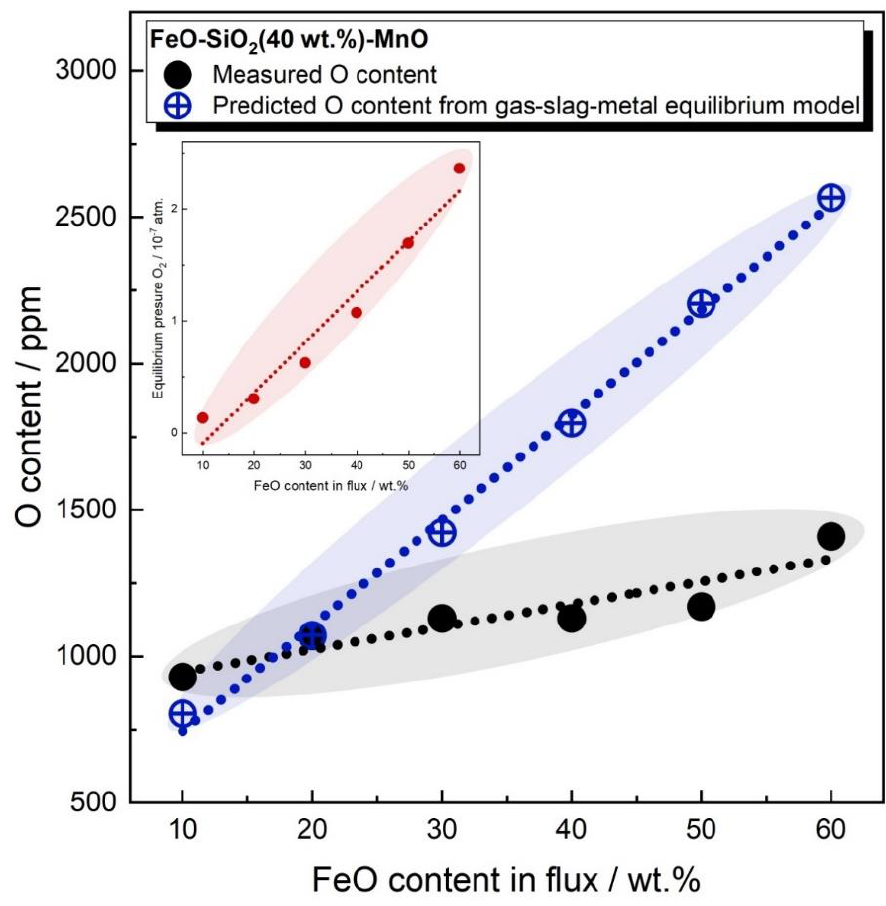
Figure 4. WM O content and equilibrium p O2 as a function FeO content in flux.